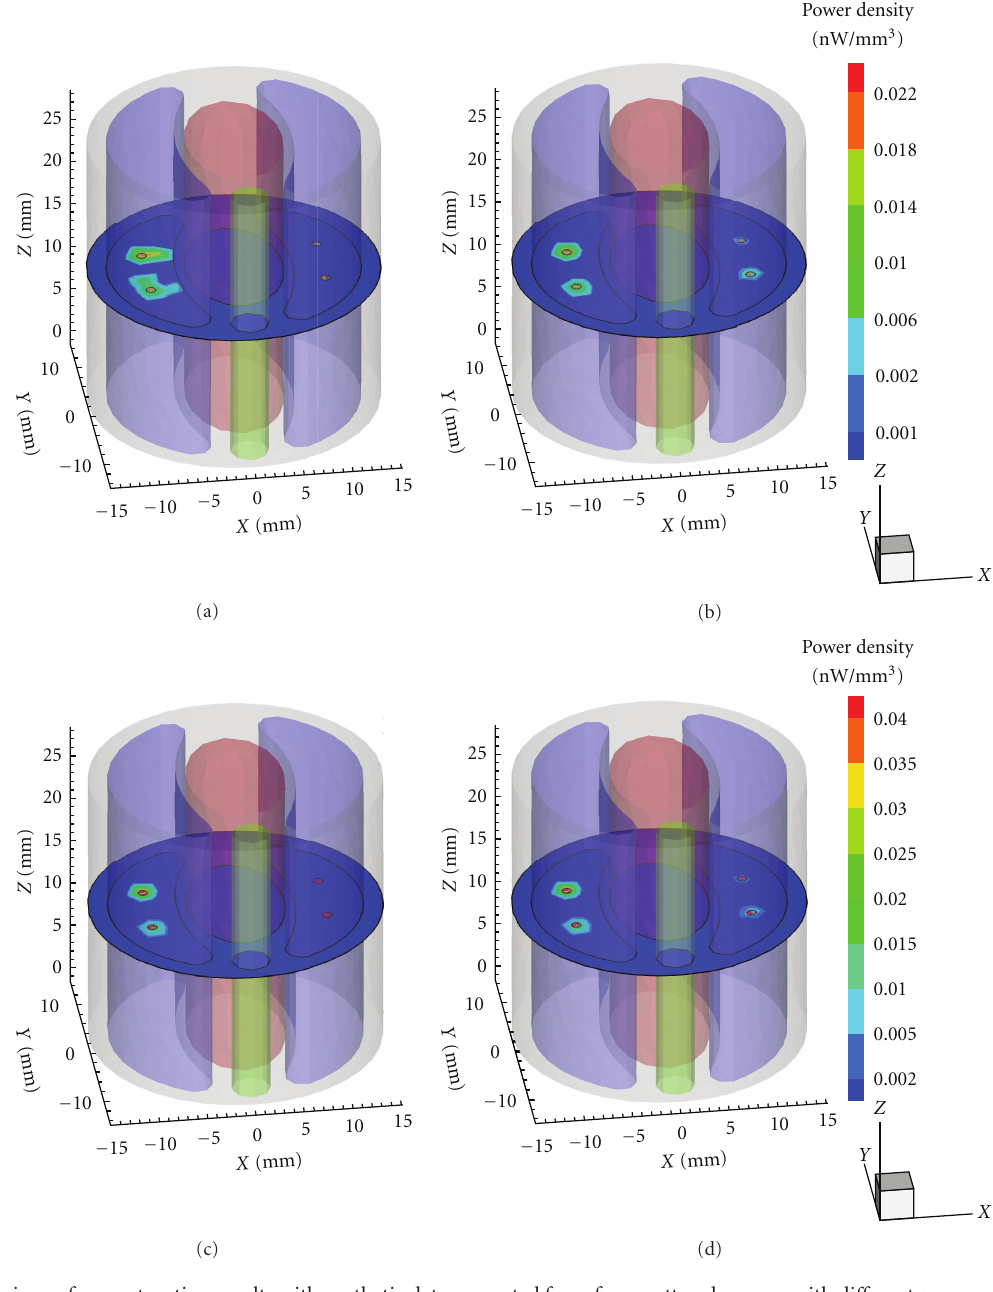
Figure 5: 3D views of reconstruction results with synthetic data generated from four scattered sources with di ff erent powers. (a)–(d) are the results of Tikhonov + GTS, l 1– ls + GTS, Tikhonov + MSDS, and l 1– ls + MSDS, respectively.